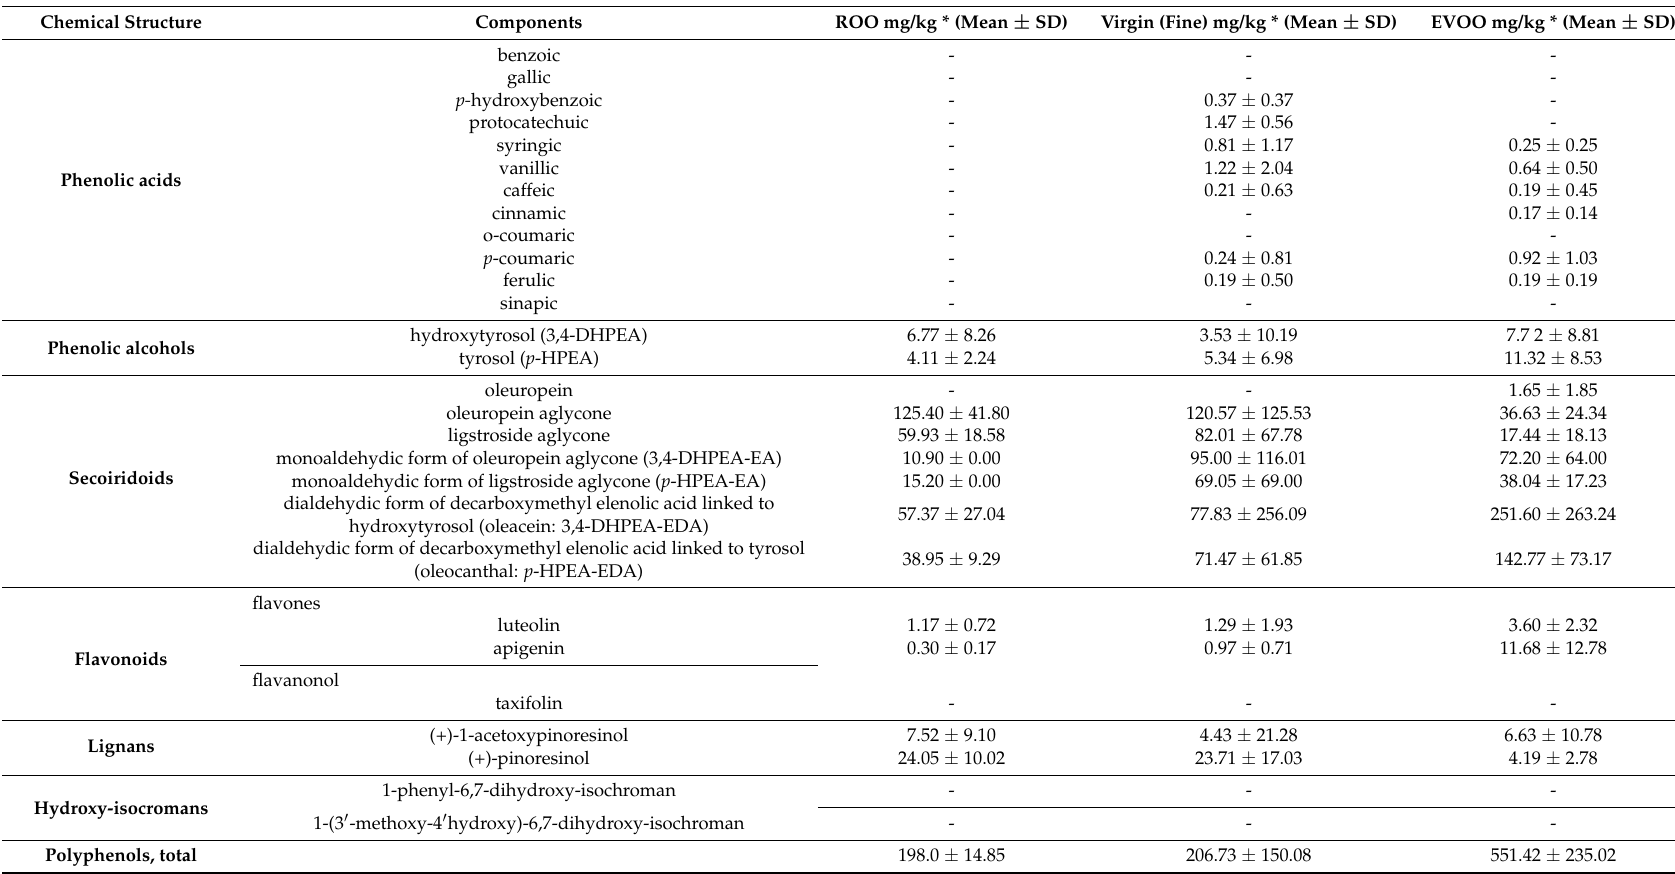
Table 1. Classification of the main hydrophilic phenolic compounds found in virgin olive oils and their average concentration in different types of olive